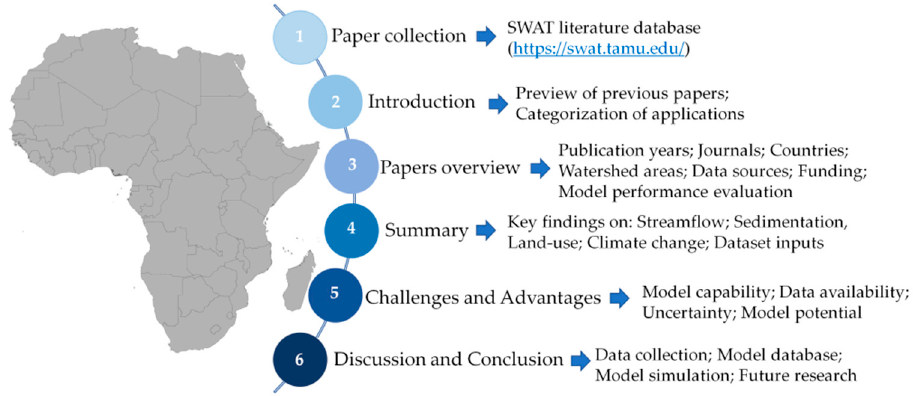
Figure 1. Methodological approach of the papers reviewed.